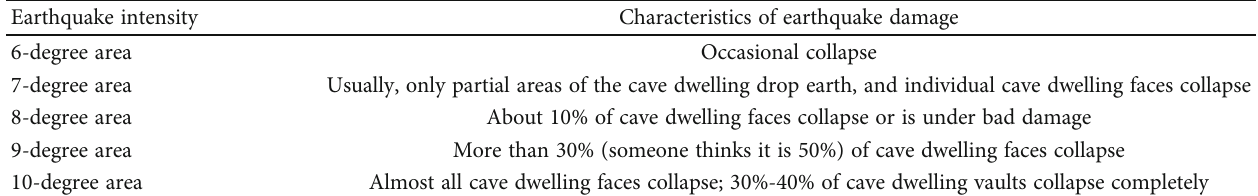
Table 4: Earthquake damage characteristics of cli ff -side loess cave dwelling in Haiyuan earthquake.